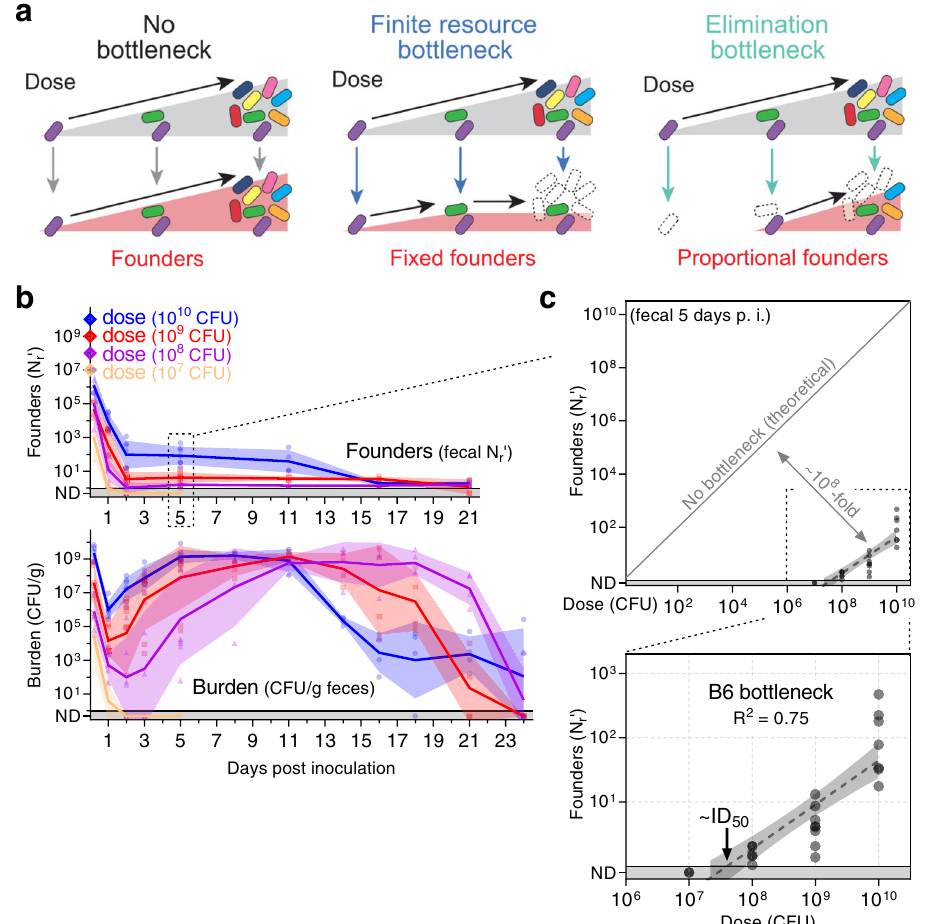
Fig. 2 | The C. rodentium bottleneck is de fi ned by a fractional relationship between dose and founders. a Models for the relationship between dose and foundingpopulation.Intheabsenceofabottleneck,allbacteriafromtheinoculum become founders. If the inoculum contracts due to the limited availability of fi nite nutrients or niches (e.g. iron, sugar, binding sites), the diversity of the population andthusthesizeofthefoundingpopulationwillremain fi xedoncethosenutrients are saturated. If increasing dose increases the number of founders, then the underlyingmechanismisnotduetoalimitedresource;instead,thebottleneckacts proportionally on the inoculum by eliminating potential founders. b , c C57BL/6J